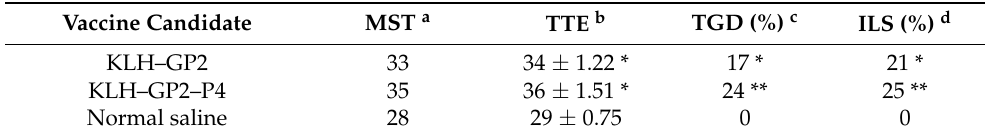
Table 2. Therapeutic efficacy of different vaccine formulations used against a TUBO breast tumor in the BALB/c mice